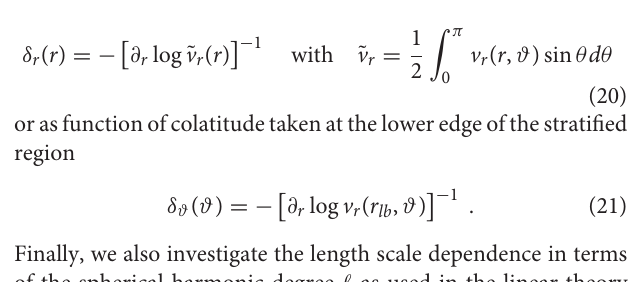
FIGURE 7 | Penetration depth of radial flows as a function of colatitude for nine cases from Table 1 , group 4 taken at the lower edge of the SSL r line shows the thickness of an Ekman layer δ ν